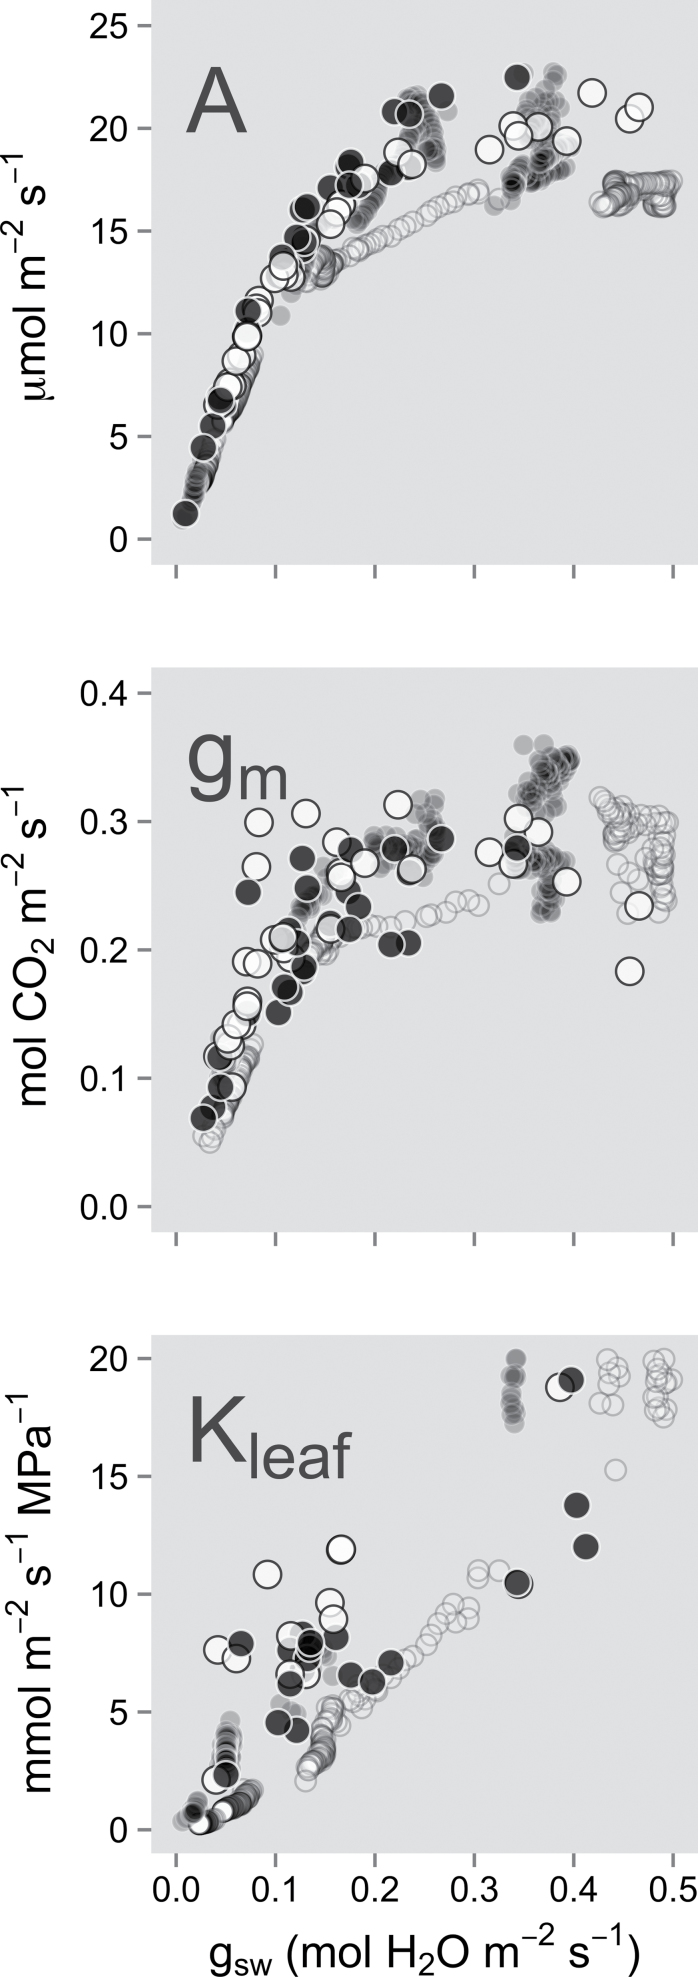
Changes in photosynthesis (A), mesophyll conductance (g
m), and leaf hydraulic conductance (K
leaf) in relation to stomatal conductance to water (g
sw) during a short-term, moderate water stress. Three plants per clone were measured over 12 d of reduced irrigation, using the same leaf per plant. Assiniboine (drought sensitive; open circles), Okanese (drought tolerant; filled circles). Data from a separate 5 day soil drying experiment are also shown (translucent circles; one plant per clone; same colour code).